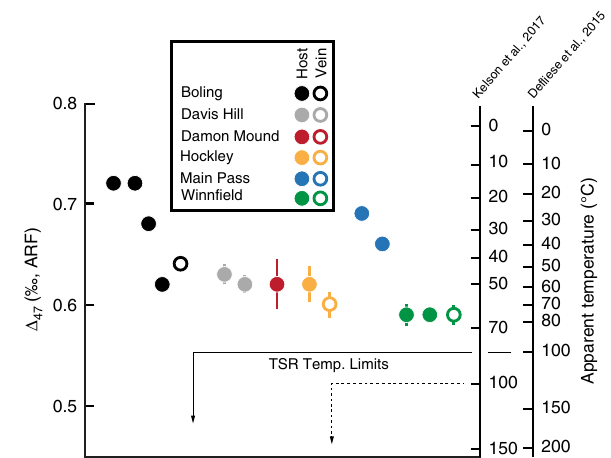
Fig. 6 Clumped isotope data from Gulf of Mexico Basin cap rock carbonate. Notice that in all cases, calculated temperatures fall below the thermochemical sulfate reduction (TSR) lower limit. Error bars correspond to ±2 standard errors (s.e.)